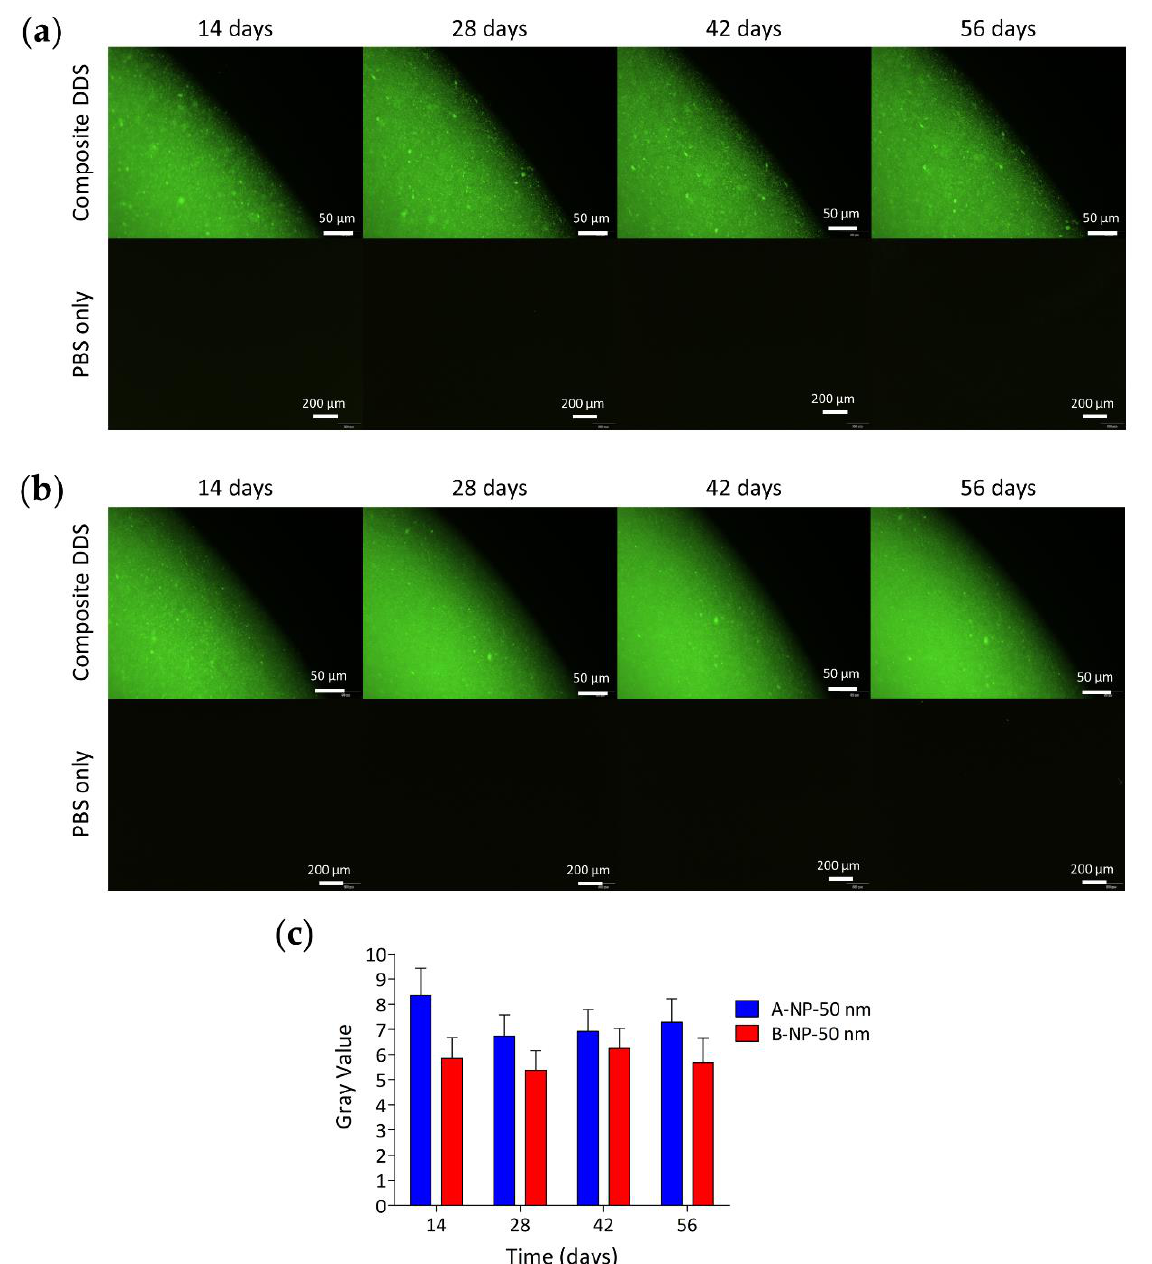
Figure 7. Distribution of 50 nm PS fluorescent nanoparticles in the hydrogel with a polymer concentration of 1.5% and 3% are shown in ( a ) and ( b ), respectively. ( c ) Represents the intensity of emitted fluorescent green light from the PBS solution of two hydrogel groups through 56 days of observation. The data show that PS NPs were more easily diffused to the surroundings when carried by groups with lower hydrogel polymer concentration.